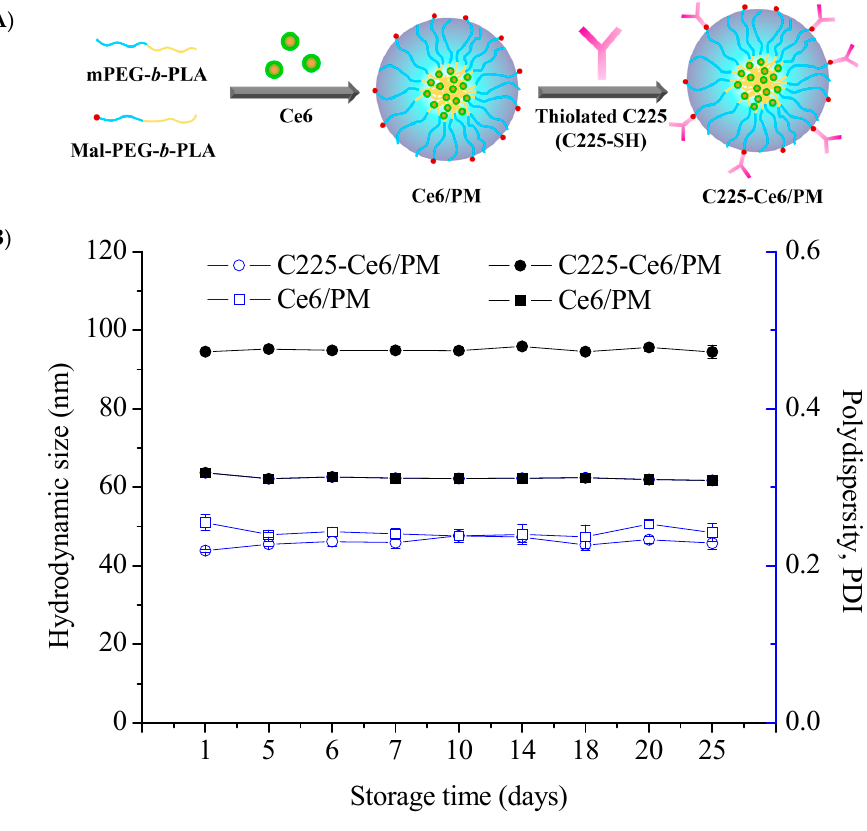
Figure 1. ( A ) Schematic representation of chlorin e6 (Ce6)-loaded micelles and cetuximab (C225)-conjugated Ce6-loaded polymeric micelles (C225-Ce6/PM); ( B ) Change in the particle size and PDI of Ce6/PM and C225-Ce6/PM over time at 4 °C measured by dynamic light scattering DLS. 2.2. Cellular Uptake of Ce6-Loaded Micelles with or without C225 Conjugation